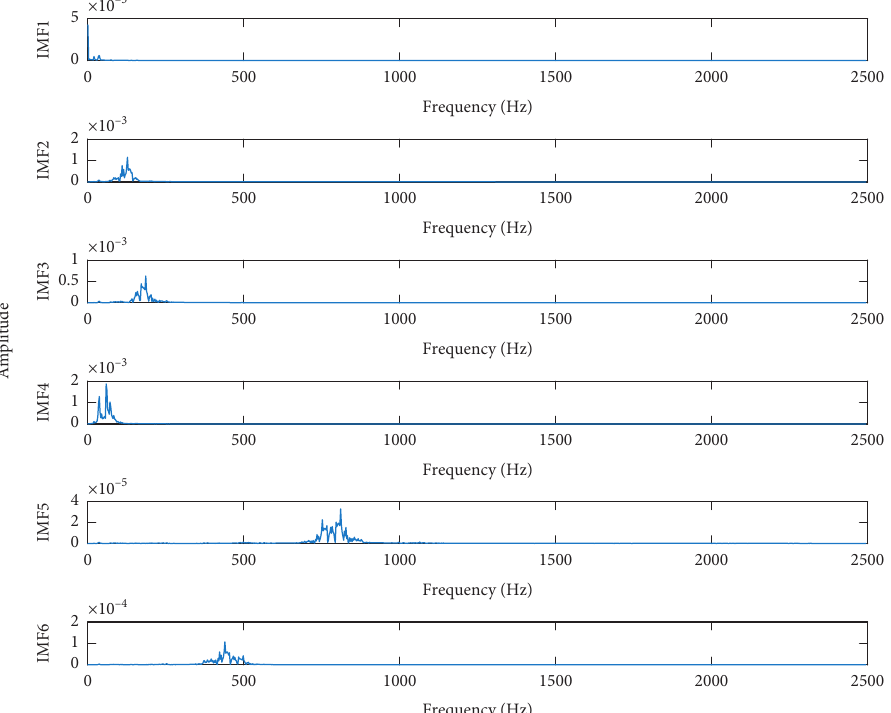
Figure 15: The frequency-domain diagram after rolling element fault signal decomposition.